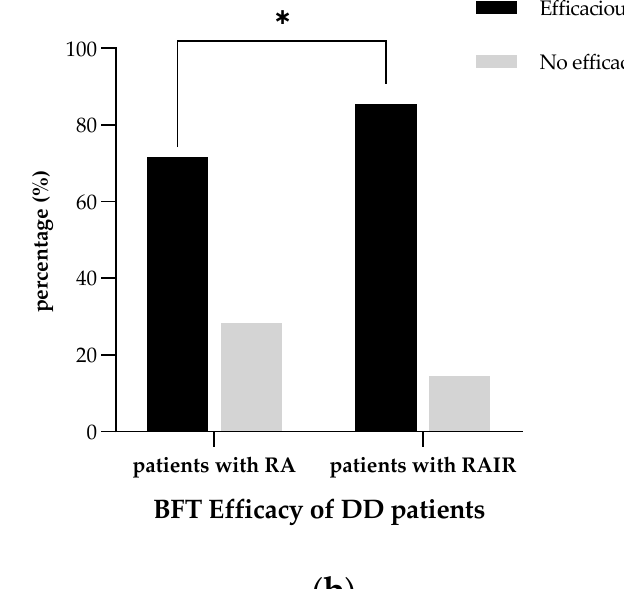
Figure 4. The response rate to BFT: ( a ) patients with FC and ( b ) patients with DD. * p < 0.05 using the chi-squared test. Abbreviations: BFT, biofeedback therapy; DD, dyssynergic defecation; FC, func- tional constipation; RA, rectoanal areflexia; RAIR, rectoanal inhibitory reflex.